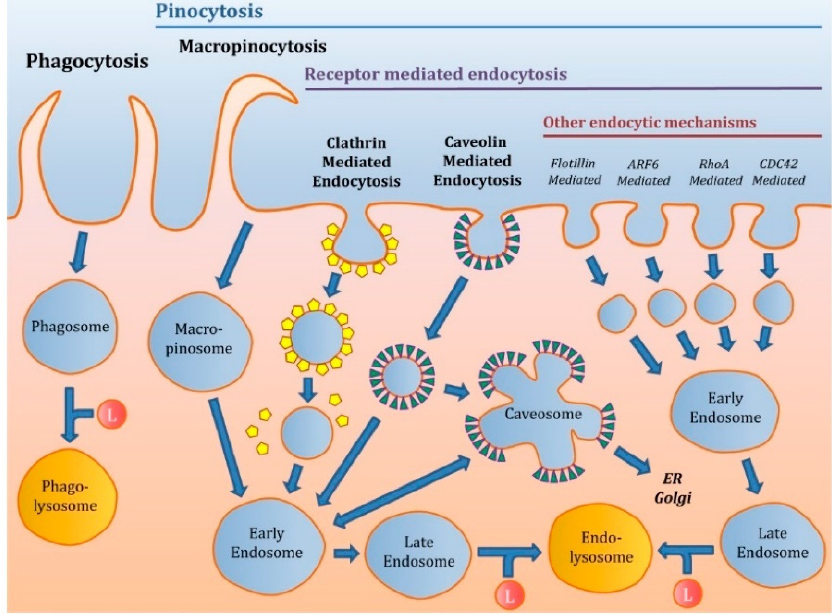
Figure 2. Different mechanisms of endocytosis. Adapted from [76]. Open access.